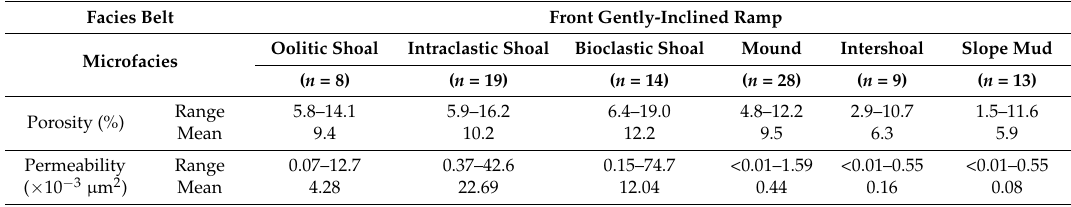
Table 1. Values of porosity and permeability from different environment of the front gently inclined ramp in Well